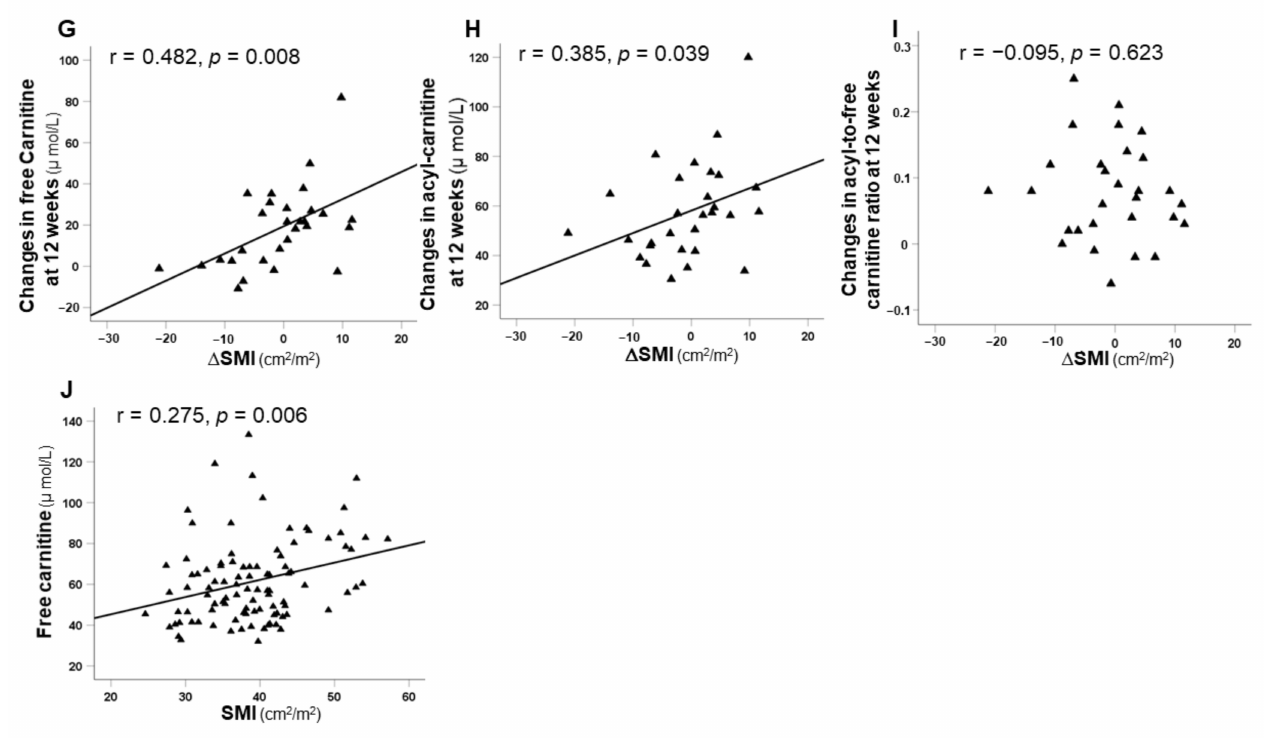
Figure 5. Correlations between baseline skeletal muscle index (SMI) scores and serum carnitine levels ( A – C ), correlations between changes in SMI from baseline ( ∆ SMI) and changes in serum carnitine levels ( D – I ) at 6 and 12 weeks, and correlation between all SMI scores and all free carnitine values over 12-week period ( J ).